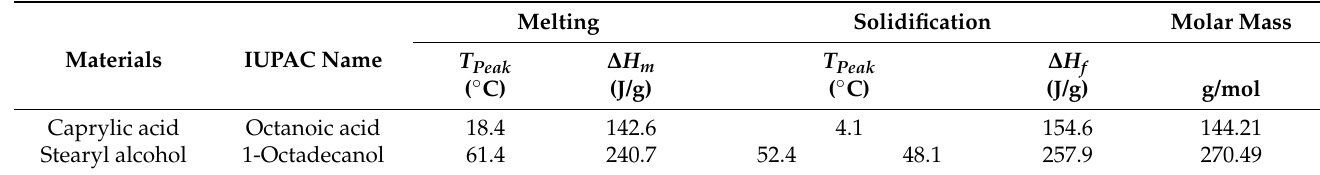
Table 2. Thermo-physical properties of pristine